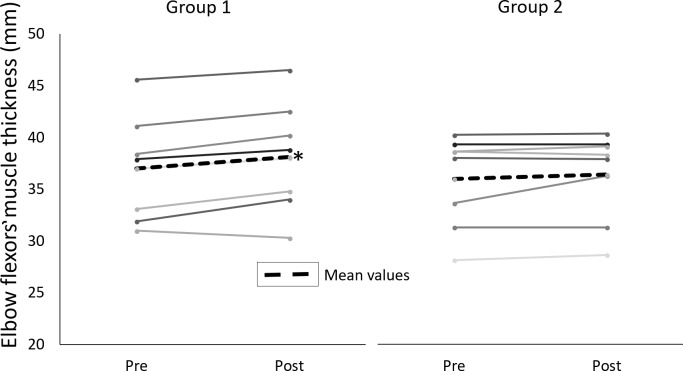
Changes in muscle thickness of elbow flexors.Individual values for pre- and post-training muscle thickness of elbow flexors (mm). Group 1 trained each muscle group once a week and Group 2 trained each muscle group twice per week. * significant difference between pre- and post-values (p < 0.05).